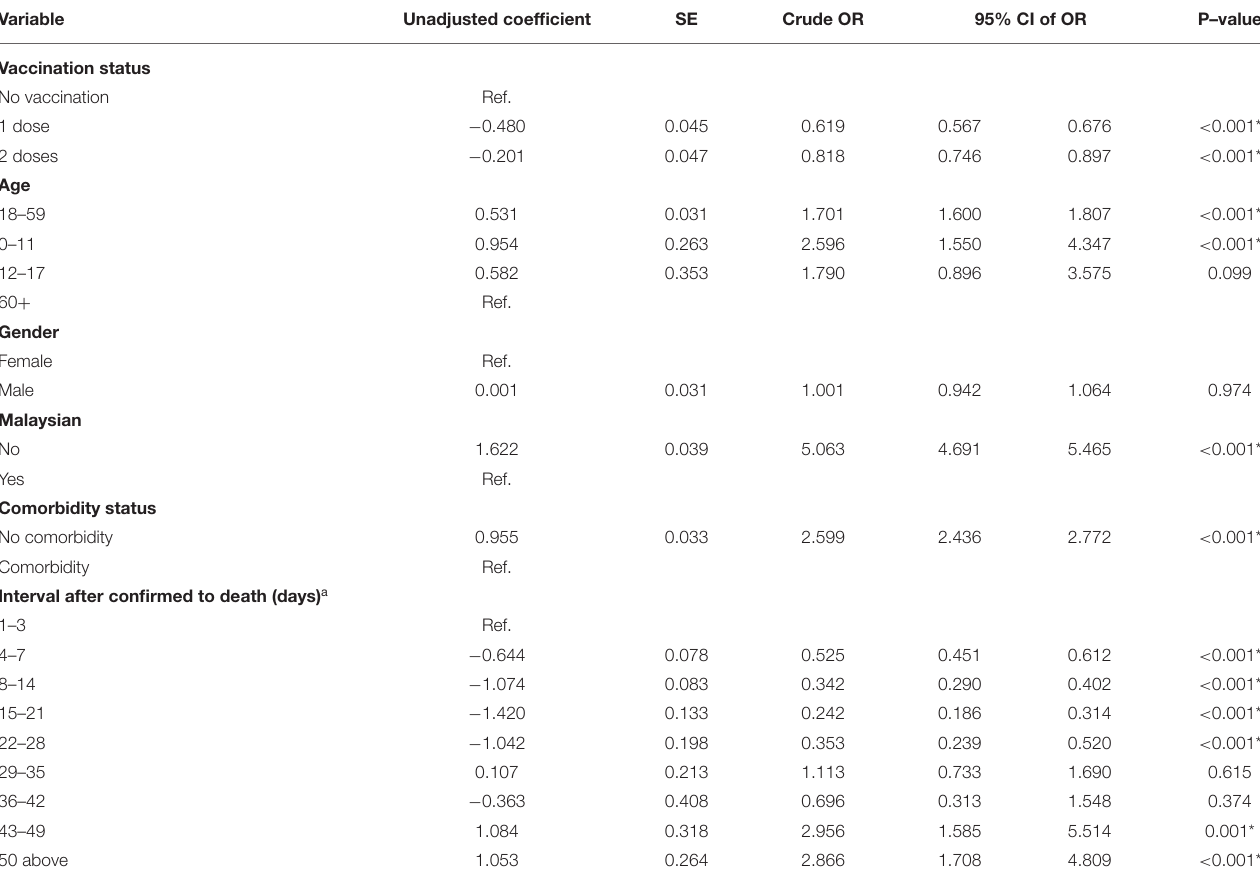
TABLE 3 | Factors associated with probability to BID using the univariate multilevel logistic regression model. Variable Unadjusted coefficient SE Crude OR 95% CI of OR